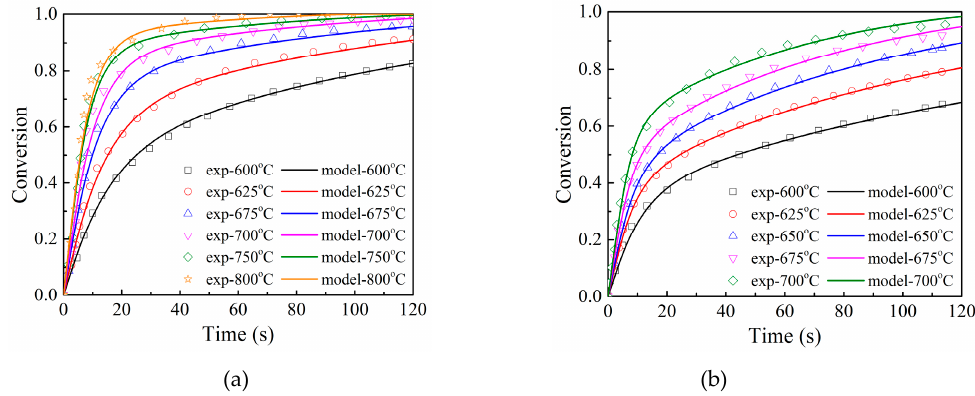
Figure 6. Effects of temperature on conversion of ( a ) 50_TiO 2 material and ( b ) 45_ZrO 2 material. ([O 2 ] = 21 vol%, [N 2 ] = 79 vol%. Dots: experimental data [16]; lines: calculated results.)